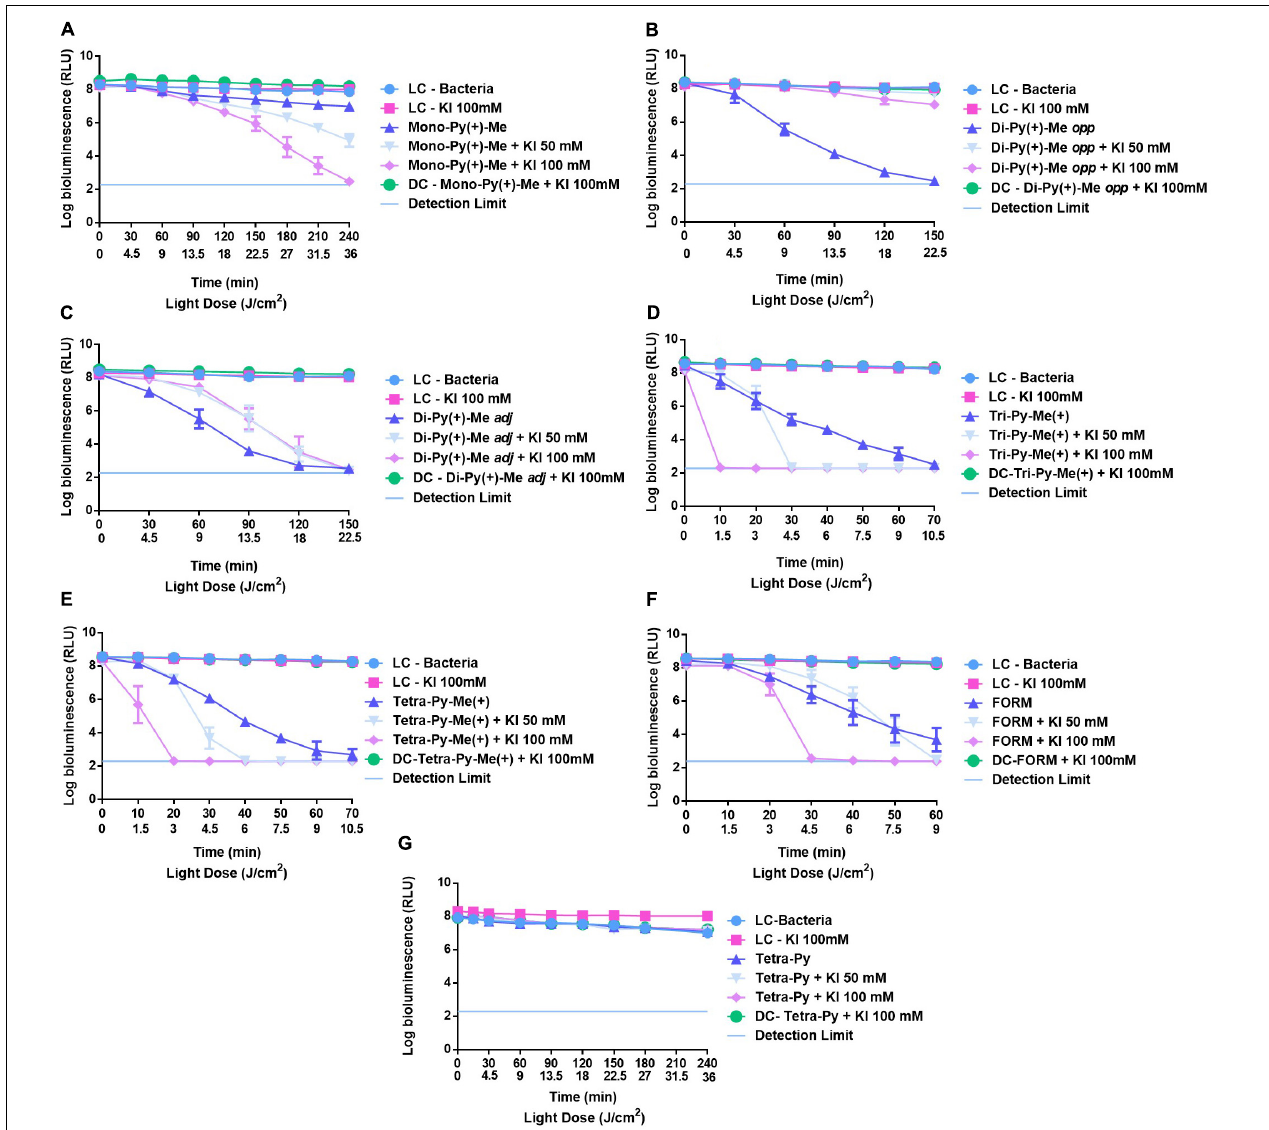
FIGURE 4 | Survival of bioluminescent E. coli during aPDT assays in the presence of Mono-Py(+)-Me (A) , Di-Py(+)-Me opp (B) , Di-Py(+)-Me adj (C) , Tetra-Py(+)-Me (D) , Tri-Py(+)-Me (E) , Form (F) , and Tetra-Py (G) at 5.0 µ M alone and combined with KI at 50 and 100 mM. The values are expressed as the three independent experiments; error bars indicate the